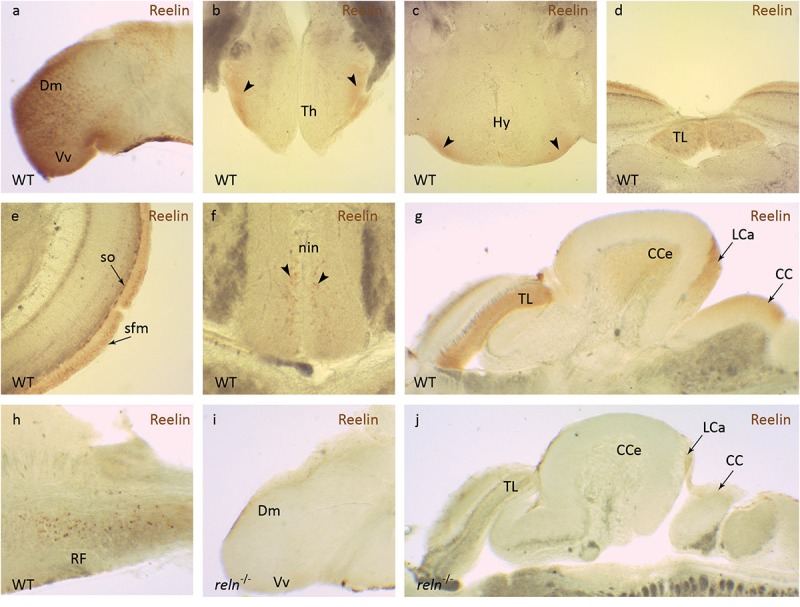
Reelin immunohistochemistry. Anti-Reelin antibody labeling of coronal and sagittal sections of the adult zebrafish brain. In wild-type anti-Reelin antibody labeling is seen in the (a) medial part of the dorsal telencephalon (Dm) and in the ventral nucleus of the ventral telencephalon (Vm), in the (b) ventral thalamic nuclei (Th) and (c) the ventral hypothalamic nuclei (Hy). Labeling is also detected in the (d) torus longitudinalis (TL), (e) stratum fibrosum marginale (sfm) and the stratum opticum (so) of the optic tectum. (f) A few labeled cells are observed in the interpeduncular nucleus (nin). In the hindbrain, Reelin protein localizes to the (g) corpus cerebelli (CCe), the lobus caudalis cerebelli (LCa), crista cerebellaris (CC) and (h) the intermediate and inferior part of the reticular formation (RF). (i,j) Anti-Reelin antibody labeling is not detected in the brain of reln–/– mutants. Black arrowheads show position of Reelin-positive areas in (b,c,f).